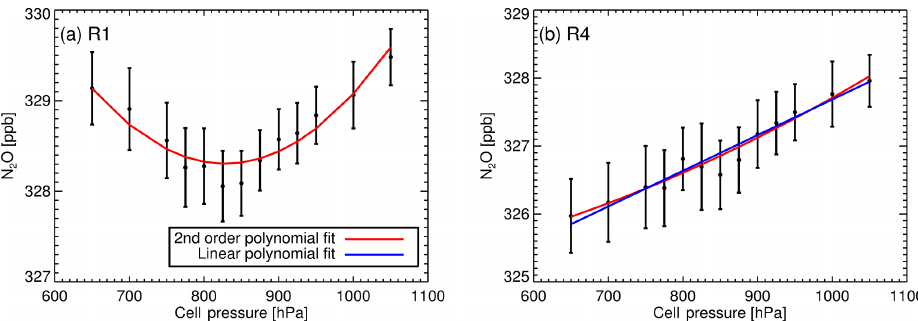
Figure A1. Retrieved N 2 O dry mole fractions as a function of cell pressure from tests conducted in December 2013. (a) Region 1 (2150–